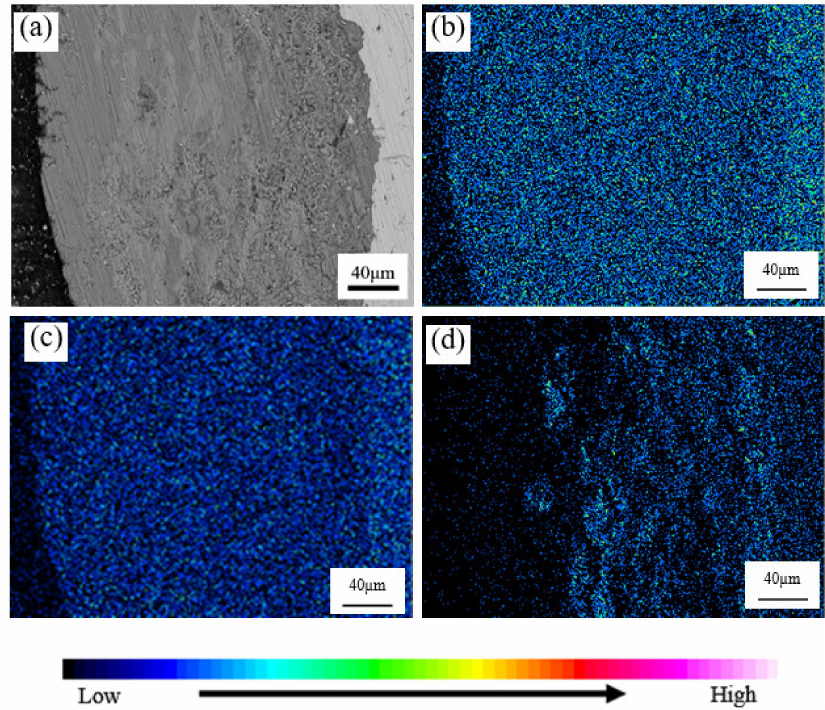
Figure 5. Cross-section morphology and element mapping distribution of rust layer section of 60Si2Mn-A sample in the period of 360 h: ( a ) cross-section of rust layer; ( b – d ) element-mapping distribution of Cu, Ni, and Cr.